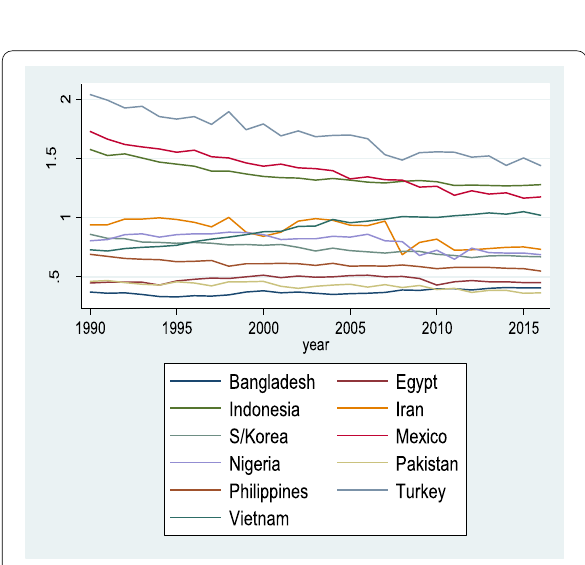
Fig. 4 Biocapacity in N11 countries